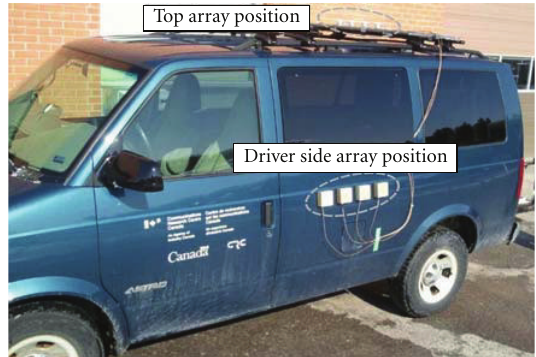
Figure 3: Photograph of the measurement vehicle showing the array positions on the top and side with the protective radomes